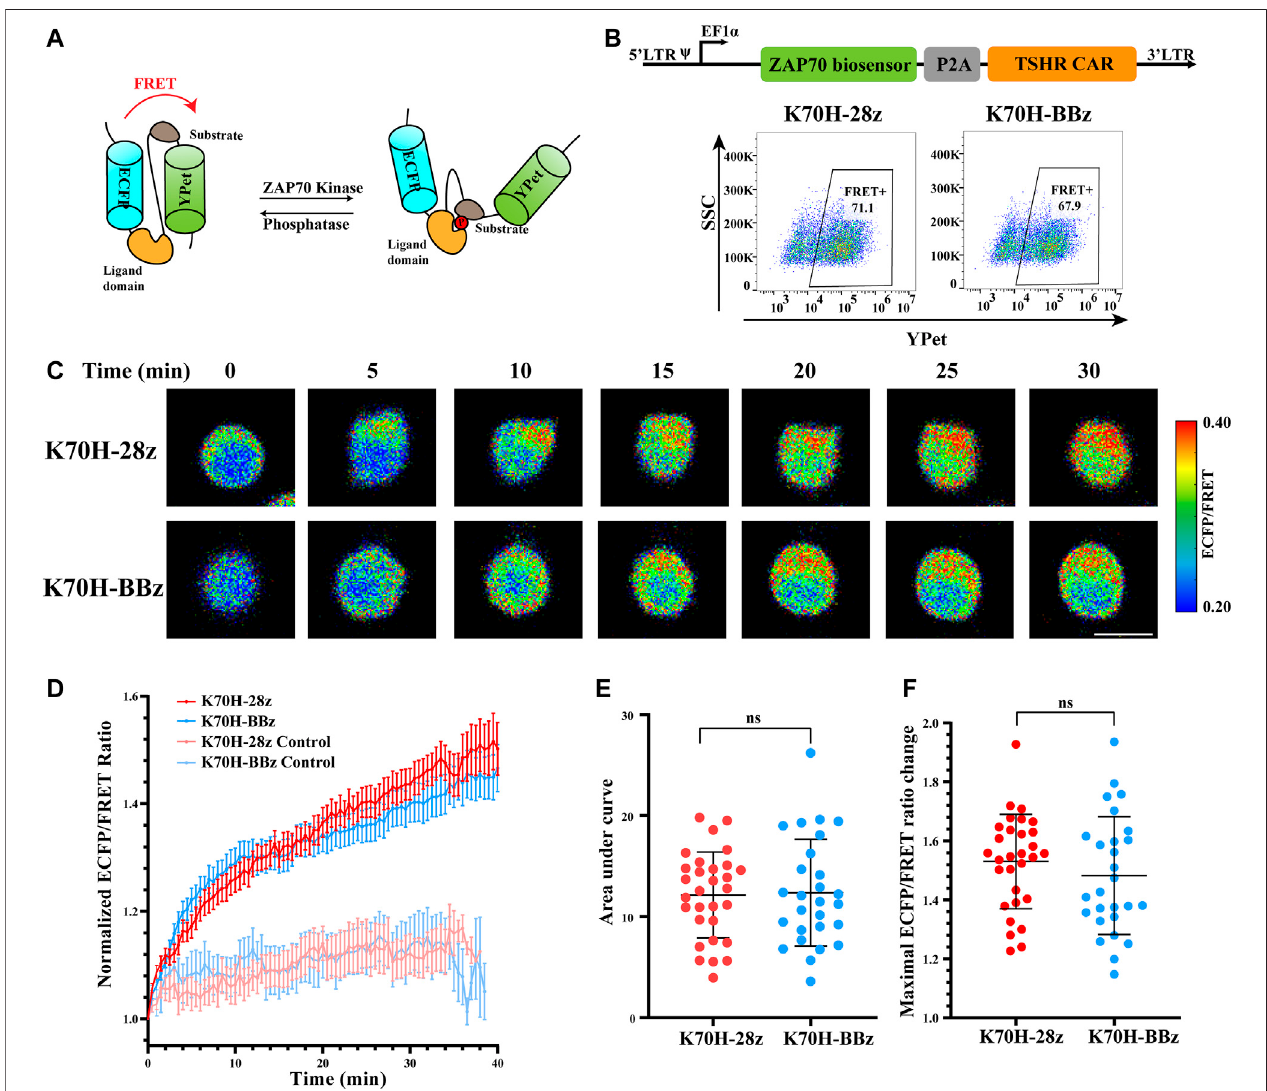
FIGURE3| Signaling dynamicsofZAP70inCAR-T cellsuponantigenstimulation. (A) DesignofZAP70FRETbiosensor. (B) Biosensor(CAR)expression ofJurkat TcellstransducedwithZAP70biosensorandTSHRCARs. (C) ZAP70signalchangesofCAR-JurkatTcellsovertimeaftercontactingwithK562-TSHRcells.Theactivity of ZAP70 was visualized by ECFP/FRET ratio. Scale bar: 10 μ m. (D) Time courses of ECFP/FRET ratio of ZAP70 biosensor in K70H-28z or K70H-BBz CAR-Jurkat T cells stimulated by K562-TSHR ( n = 30and 27respectively) or K562 (Control, n =10 and 10 respectively).Error bars: mean ± SEM. Accumulated signal intensity (area under curve) (E) and maximal ECFP/FRET ratio changes (F) of ZAP70 biosensor in CAR-Jurkat T cells. Error bars: mean ± SD.